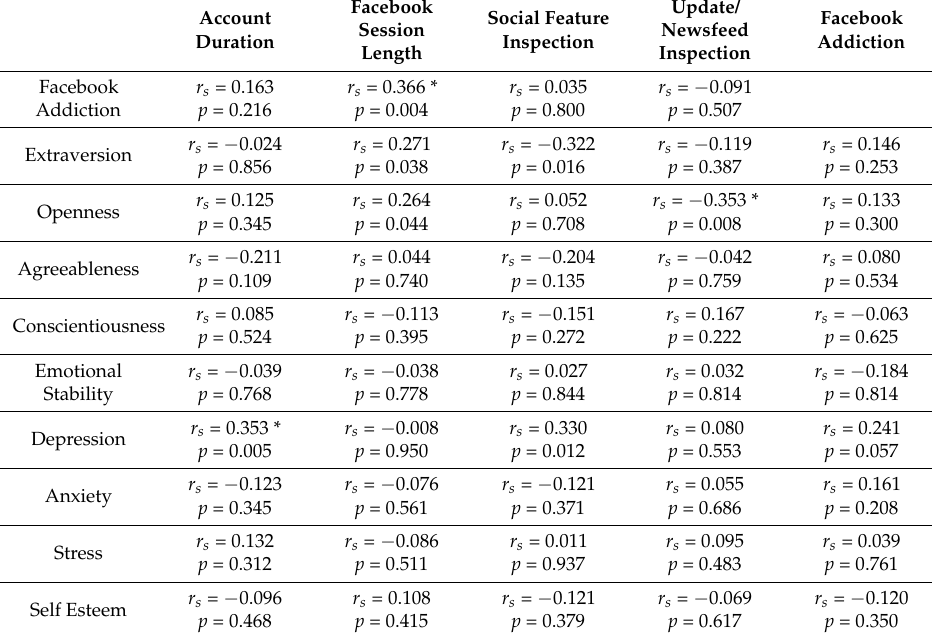
Table 2. Personality and individual differences measures and inspection time